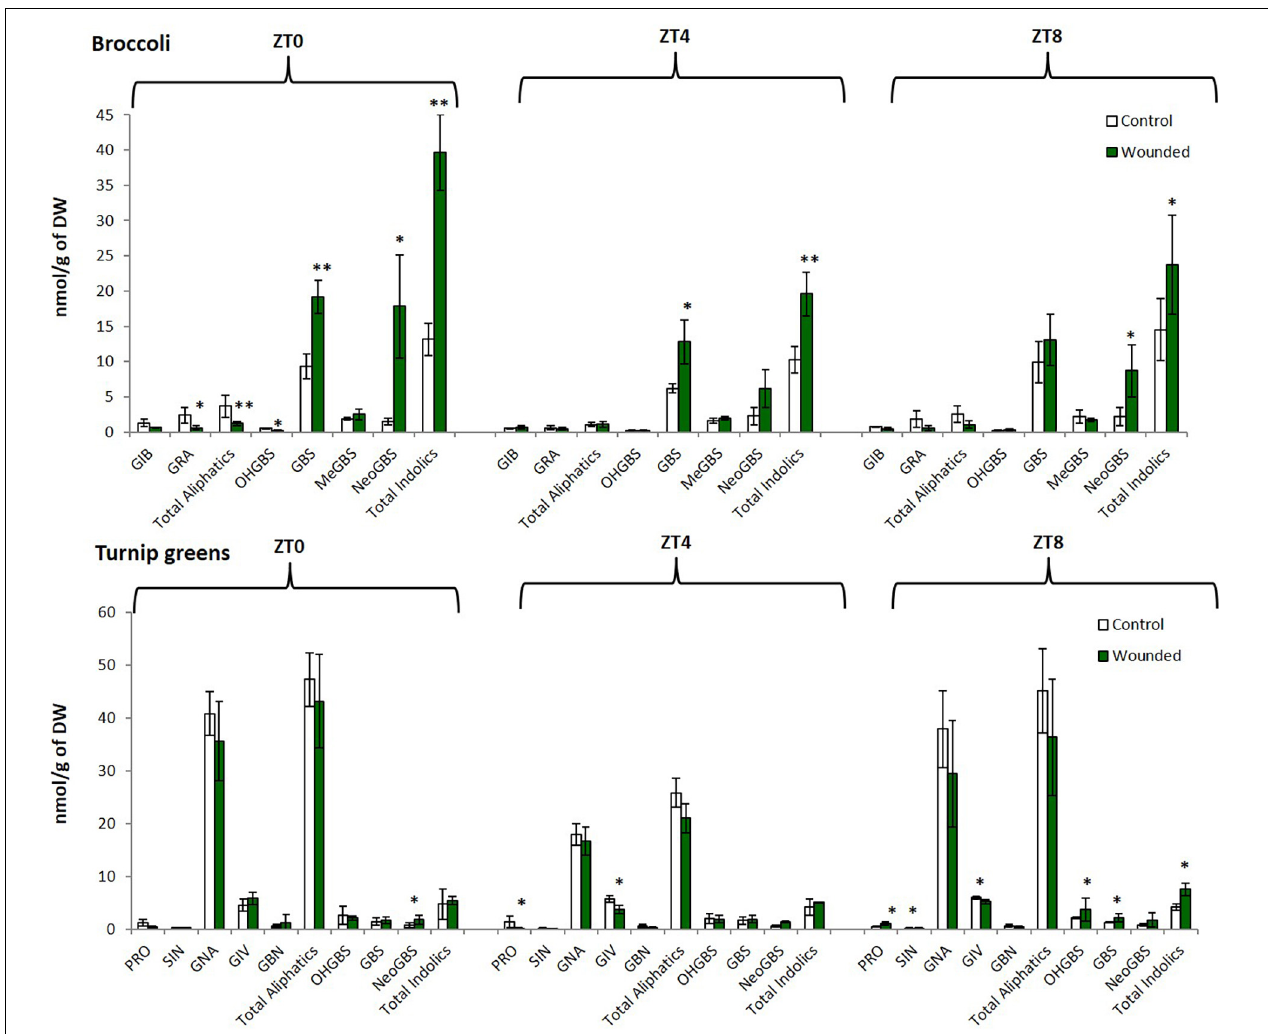
FIGURE 2 | Glucosinolate content in a commercial hybrid of broccoli “green calabrese” ( B. oleracea var. botrytis ) and a local variety of turnip greens “globo blanco de Lugo” ( B. rapa ssp. rapa ) at different time points (ZT0, dawn; ZT0, mid-day; ZT8, dusk). Error bars represent ± standard error (SE). GIB, glucoiberin; GRA, glucoraphanin; PRO, progoitrin; SIN, sinigrin; GNA, gluconasturtiin; GIV, glucoiberverin; GBN, glucobrassicanapin; GBS, glucobrassicin; OHGBS, hydroxyglucobrassicin; MeGBS, methoxyglucobrassicin; NeoGBS, neoglucobrassicin. The asterisk indicates statistically significant differences between mean values according to Student’s t -test ( ∗ p < 0.05; ∗∗ p <